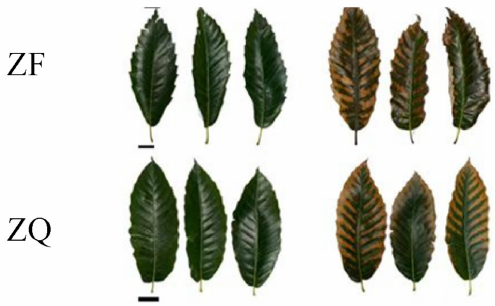
Figure 1. Healthy and scorched leaves of chestnut trees. ZF: Yanshanzaofeng; ZQ: Zhongqing No.